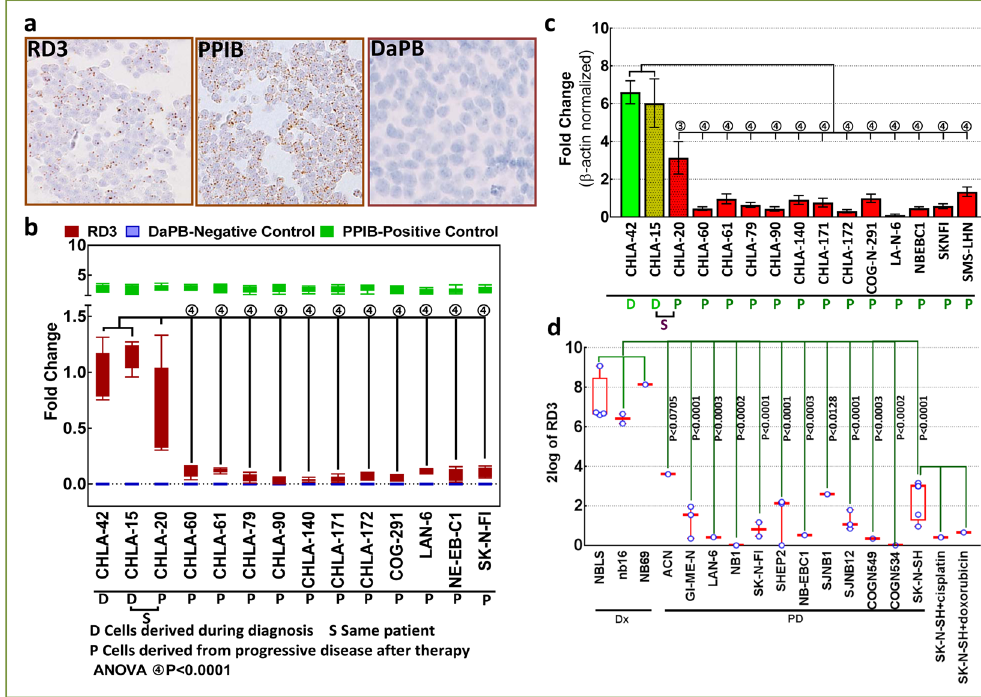
Figure 1. Transcriptional loss of RD3 with IMCT: ( a ) Representative microphotograph from RNAscope assay showing expression of RD3. All assays were performed on the custom-archived cell microarray with triplicate cores representing each cell line. Parallel PPIB and DaPB were used as positive and negative controls. ( b ) Box and whiskers plot from RNAscope analysis showing RD3 mRNA levels in MYCN-na neuroblastoma cell lines derived from stage 4 patients during diagnosis or after IMCT. Quantified levels of positive control PPIB and negative controls DapB are plotted in parallel. Compared with cell lines from diagnosis (CHLA-42 and CHLA- 15), RD3 levels were significantly reduced in cell lines derived from progressive disease (PD) after IMCT. ( c ) Histograms from QPCR analysis showing a significant decrease in RD3 mRNA levels in cell lines derived from PD after IMCT compared with those derived during diagnosis. ( d ) Data mining from publicly available independent gene profiling studies showing significant reduction of RD3 transcription (RNA-seq data) in all cell lines derived after IMCT compared with the cell lines derived during